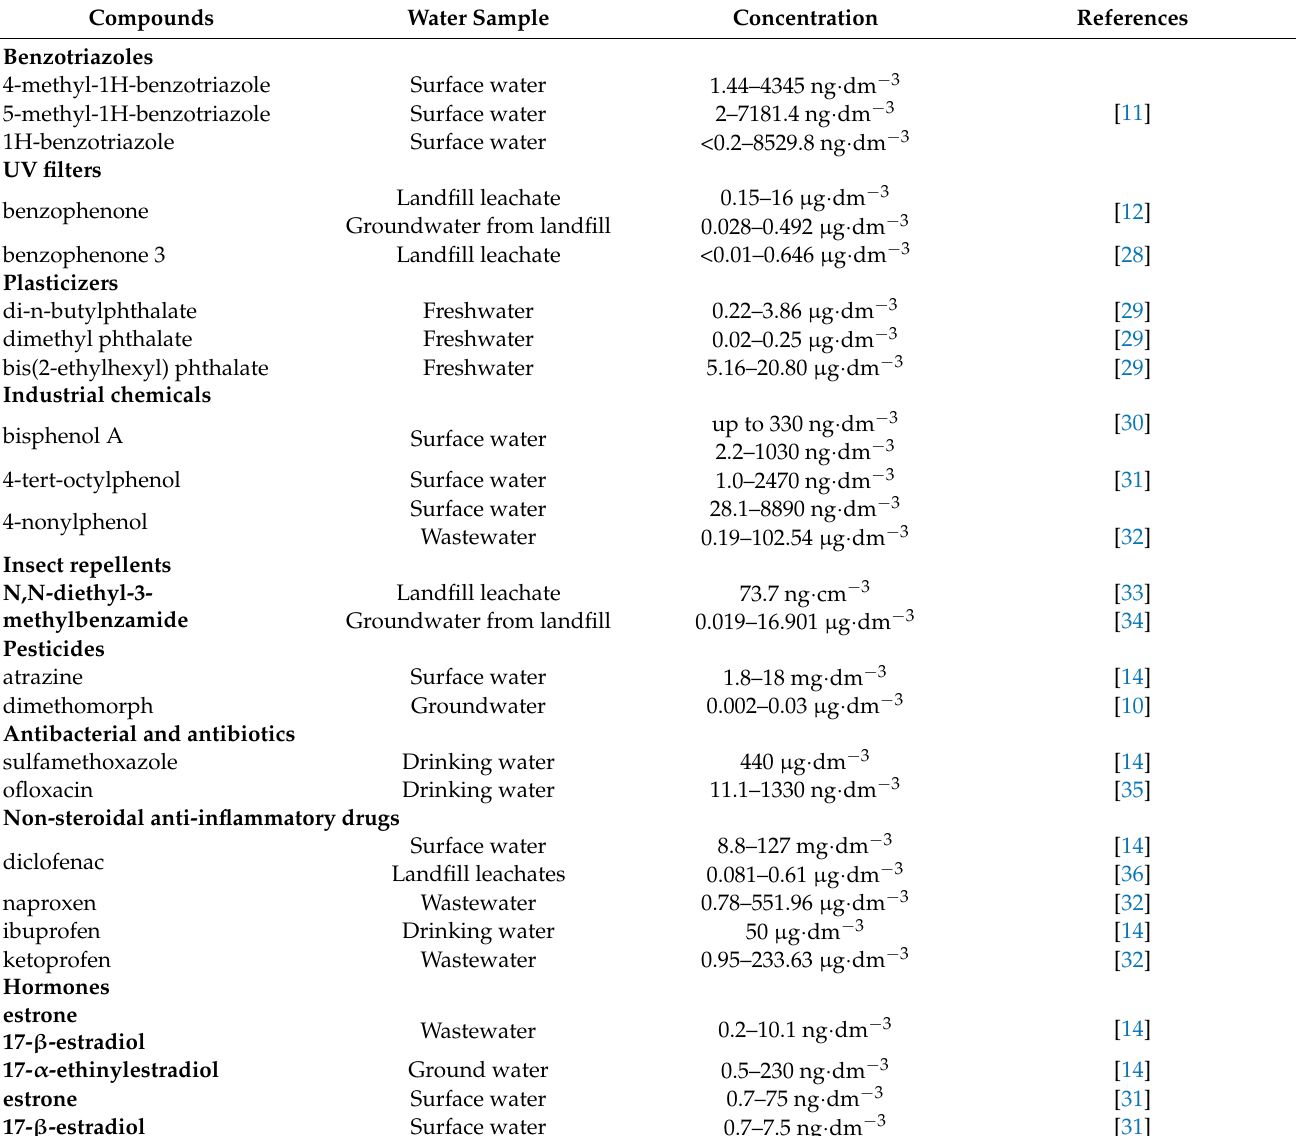
Table 1. Concentrations of selected endocrine active compounds within the